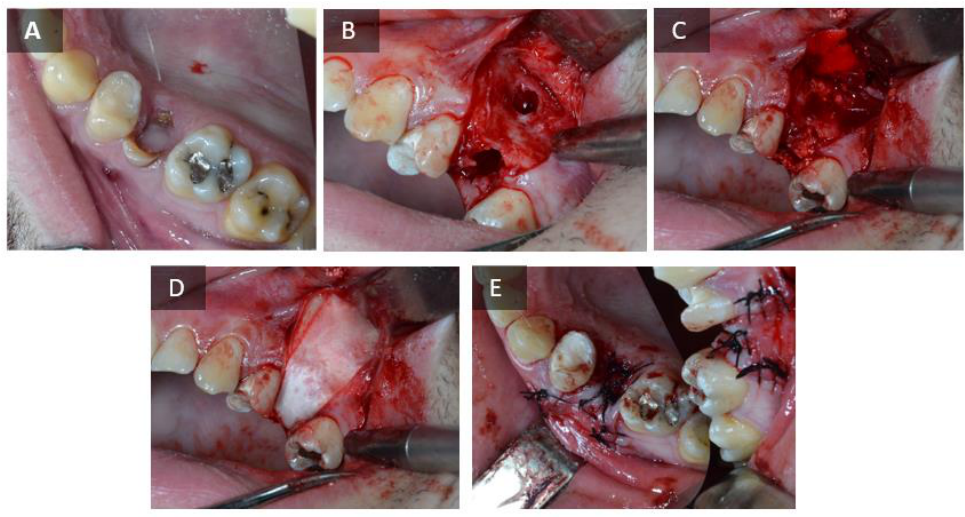
Figure 10. Surgical procedure—test group. ( A ) Hopeless tooth. ( B ) Alveolus and bone defect after extraction. ( C ) Placement of the BSB. ( D ) Placement of the resorptive membrane. ( E ) Sutured wound.